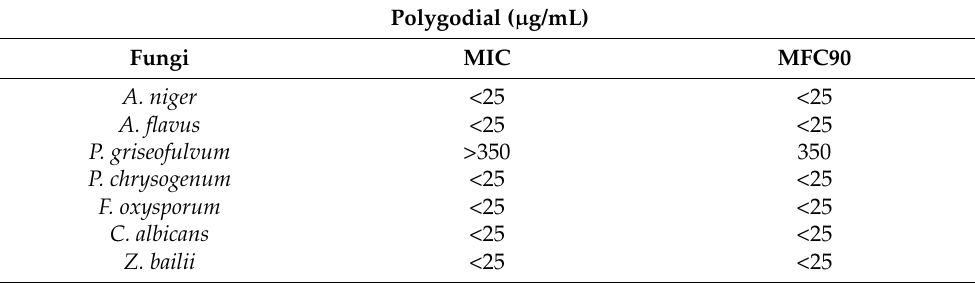
Figure 1. The effect of different concentrations of Tasmanian pepper leaf (TPL) extract on the fungal species' inhibition zones. Table 2. Minimum inhibitory concentrations (MICs) and minimum fungicidal concentrations (MFCs) of polygodial found in TPL extract against pathogenic and spoilage fungi after 24 h incubation.